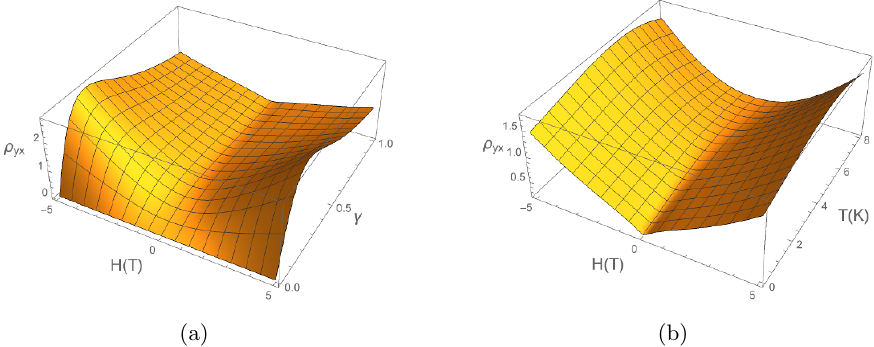
Figure 6 . Transverse resistivity (cid:26) yx , (a) as a function of Magnetic doping and magnetic (cid:12)eld at T = 0 : 01. (b) as a function of Temperature and magnetic (cid:12)eld at q (cid:31) (cid:13) = 0 : 7.